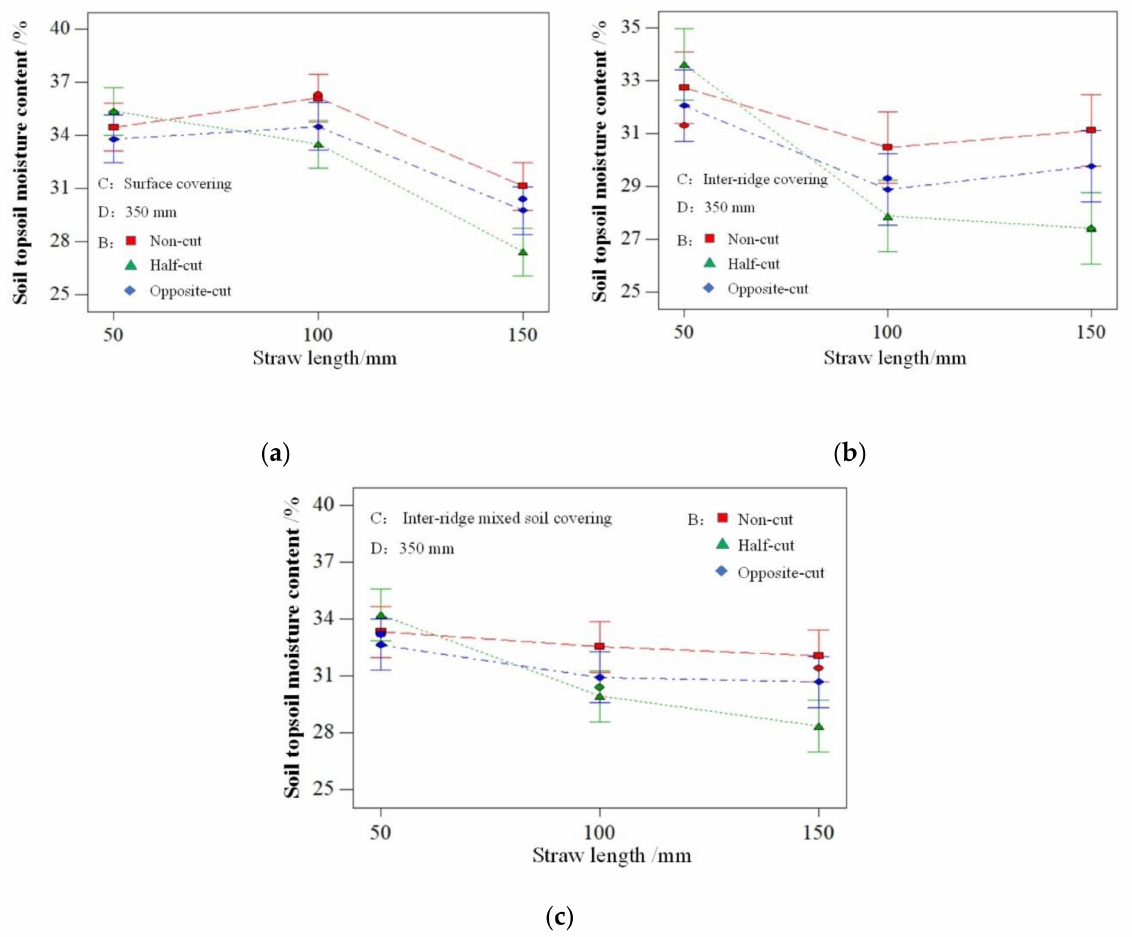
Figure 3. Effect of interaction between straw length and straw shape on soil topsoil moisture content. ( a ) The mulching form is surface covering; ( b ) the mulching form is inter-ridge covering; ( c ) the mulching form is inter-ridge mixed soil